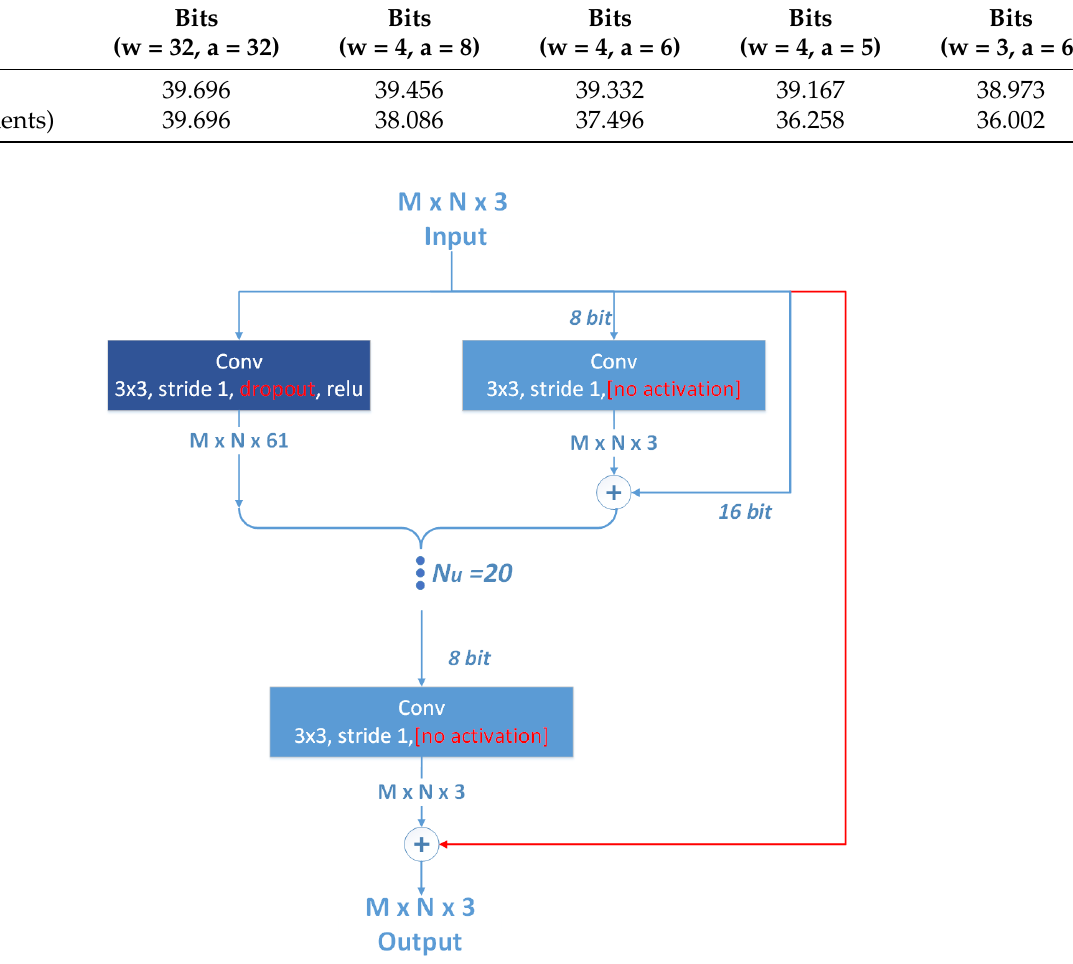
Figure 3. Model used in denoising/demosaicing